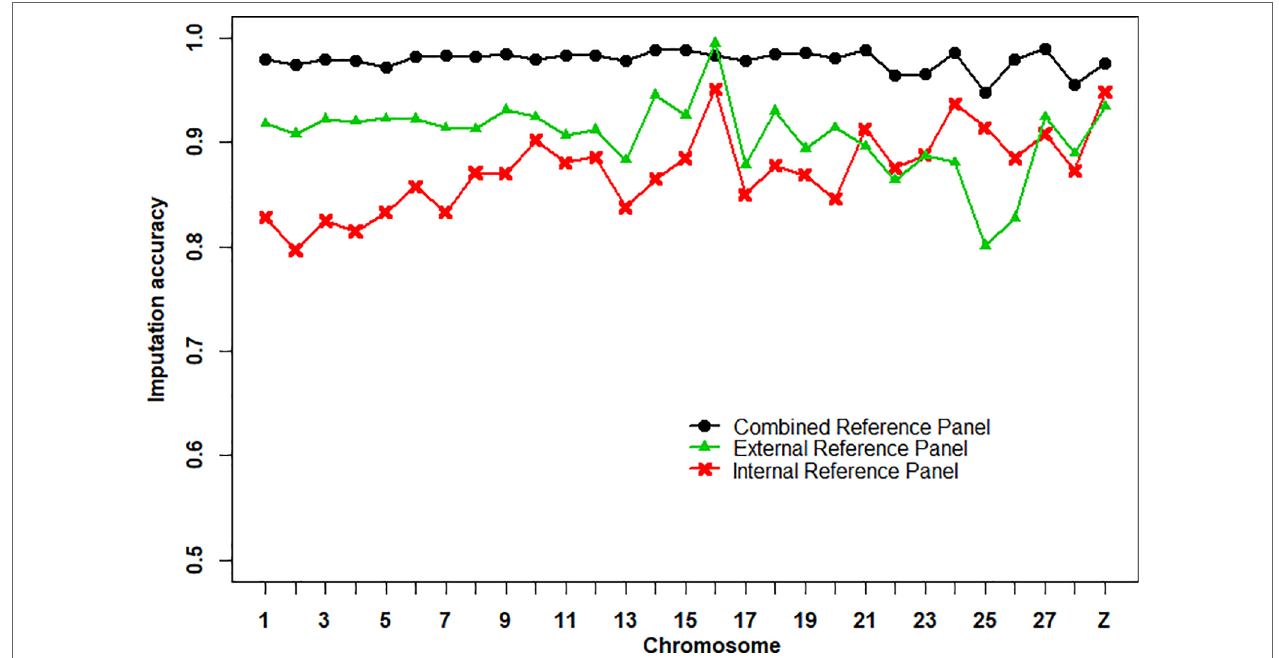
FIGURE 1 | Average imputation accuracies of Beagle 4.1 using different reference panels per chromosome. The imputation accuracy was assessed by the correlation between imputed and masked true genotypes per